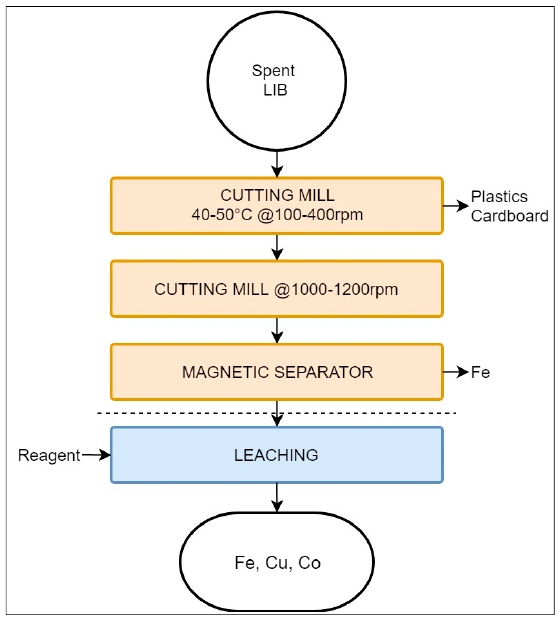
Figure 5. Schematic representation of the Akkuser recycling process.